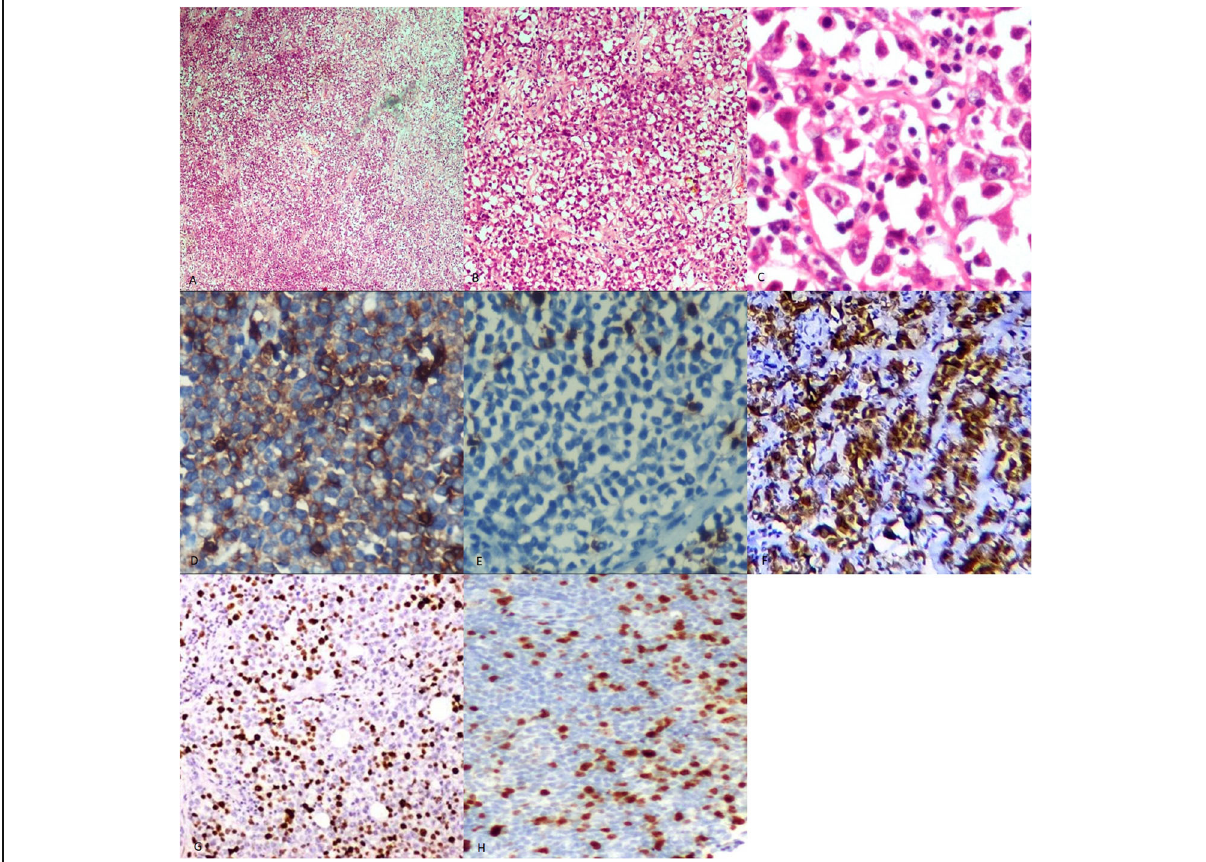
Fig. 1 Histopathology Images of Biopsy specimen done in 2015 suggestive of DLBCL. a 40× scanner view of the lymph node showing diffuse sheets of lymphoid cells. b 100× low-power view displaying atypical lymphoid cells. c 400× high-power view displaying large atypical lymphoid cells having vesicular nuclear chromatin and prominent nucleolus. d 100× CD20 positive. e 100× CD10 negative. f 100× Bcl 6 positive. g 100× Bcl2 positive. h 100× Ki-67 Proliferation Index was